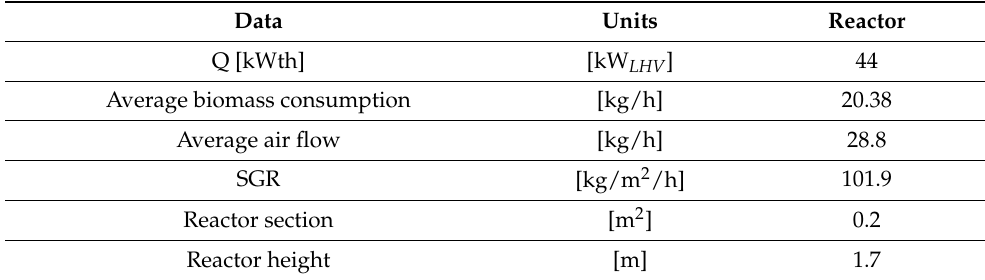
Table 7 sums up the main characteristics of the designed reactor: Table 7. Specific design characteristics of the semi-batch fixed downdraft